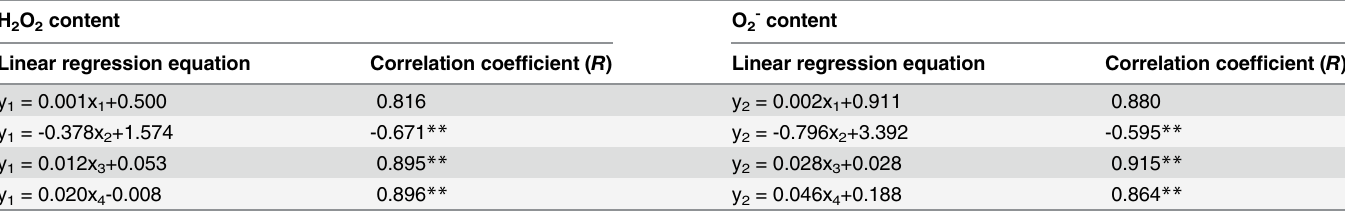
Table 4. Relationship between the H 2 O 2 (O 2- ) contents and the CAT activity, POD activity and reduced AsA content in soybean roots treated with La 3+ and AR. H 2 O 2